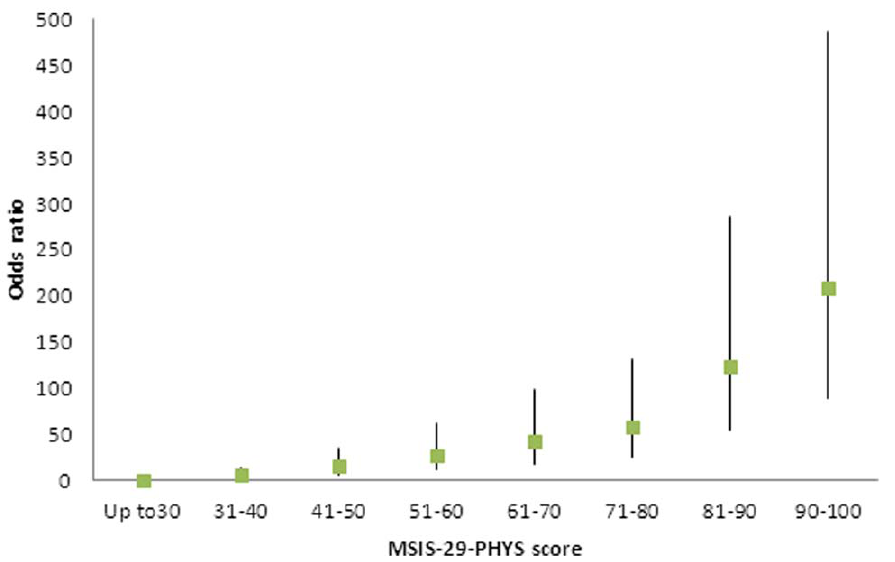
Figure 6. Odds ratios of the workforce being sick/disabled. Logistic regression was conducted to predict the odds of members of the workforce being sick/disabled based on their MSIS-29-PHYS scores in bands of 10 (above the minimum score of 20), relative to the lowest band (up 30). The upper and lower confidence intervals are indicated by vertical lines.